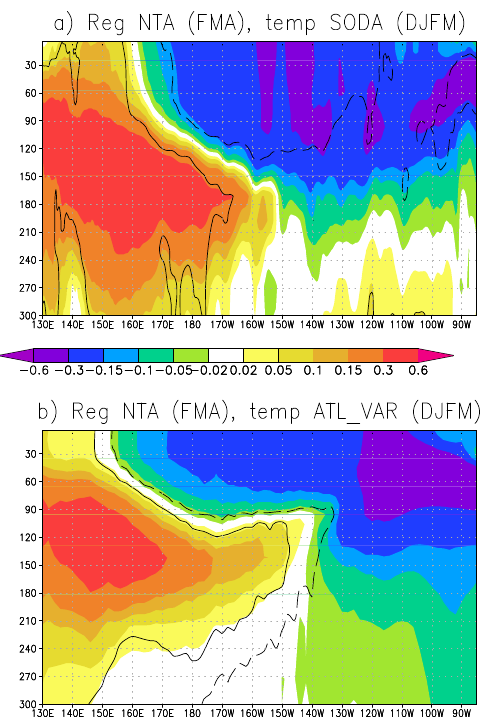
Figure 5. Regression of ( a ) observed and ( b ) ATL_VAR SLP and low-level winds (DJFM) onto preceeding (FMA) NTA index. SLP anomalies that are 95% statistically significant are indicated by contours, and only statistically significant wind vector components are shown. Units are hPa for SLP and m/s for winds.